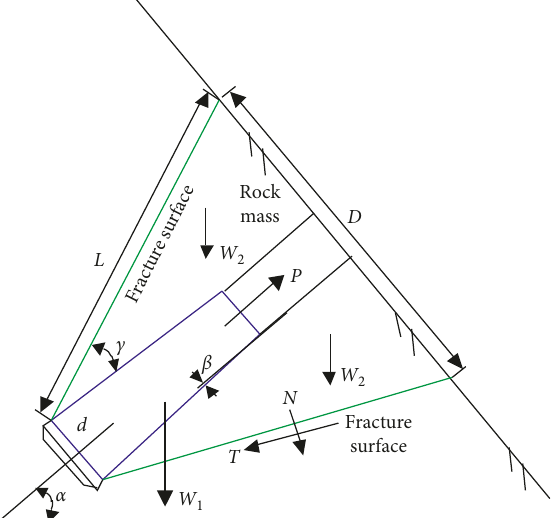
Figure 10: Schematic of the stress of TTAs with a wedge failure mode.